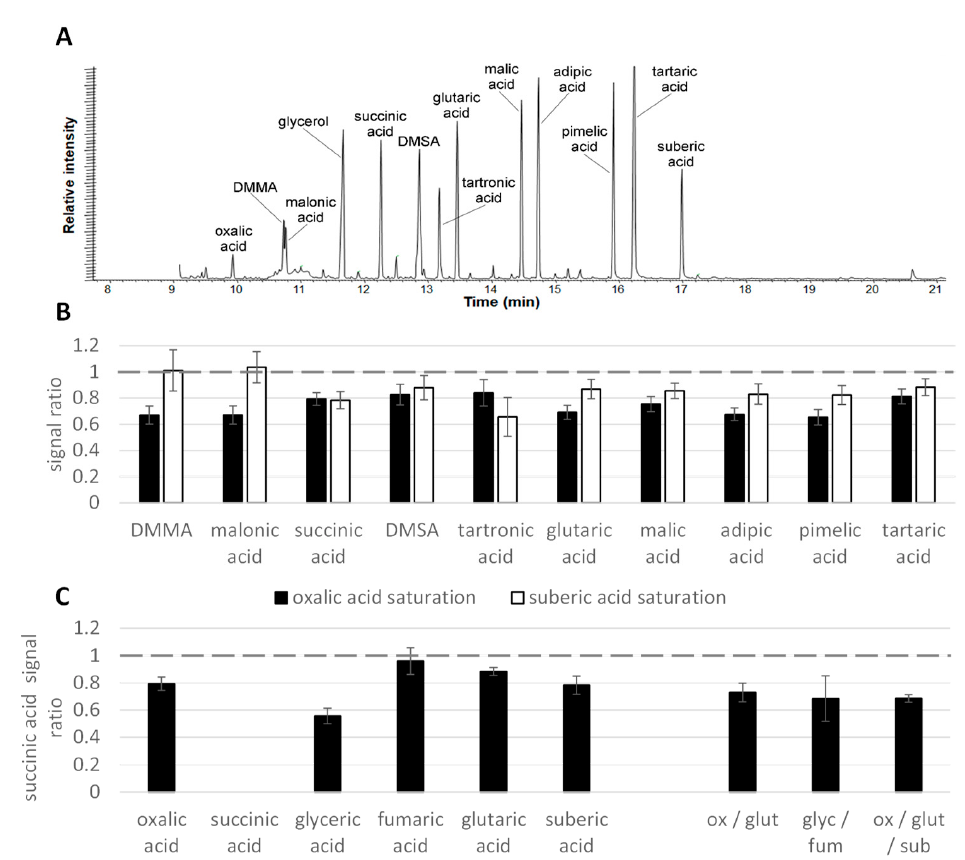
Figure 2. Matrix effects between organic acids. ( A ) Chromatogram illustrating the elution order of the investigated organic acids. ( B ) Recovery of ten organic acids (120 µM) in presence of oxalic or suberic acid in saturation (5 mM). DMMA—dimethylmalonic acid; DMSA—dimethylsuccinic acid. Analytes are arranged in the order of increasing retention as a proxy for decreasing volatility. Note that oxalic acid has the lowest retention, and suberic acid is the highest of the used acids. ( C ) Succinic acid (120 µM) recovery in presence of other organic acids in saturation (5 mM) as indicated on the x -axis. Succinic acid was included to illustrate the retention order: oxalic acid (ox) elutes ~2.4 min before succinic acid, followed by glyceric (glyc), fumaric (fum), and glutaric (glut) acids at ~0.4 min intervals and suberic acid (sub) 5 min after glutaric acid. All samples were analyzed on an Agilent GC